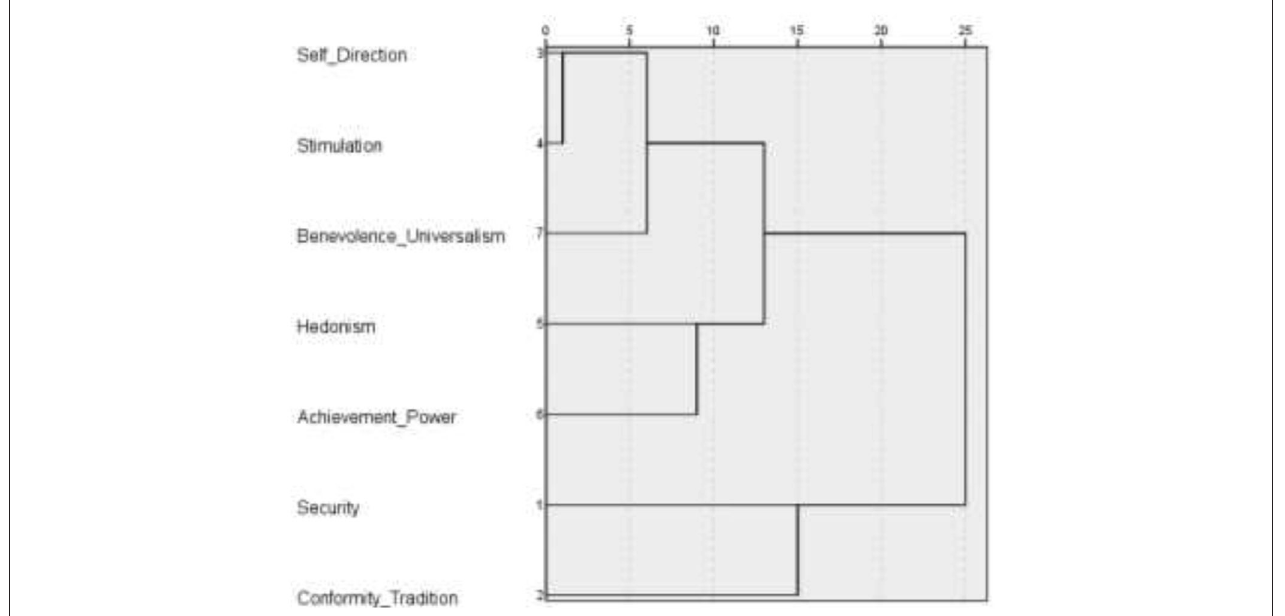
FIGURE 2 | Classification of Russians’ value orientation during the COVID-19 pandemic (PVQ-21). Dendrogram of hierarchical cluster analysis (intergroup communication method).